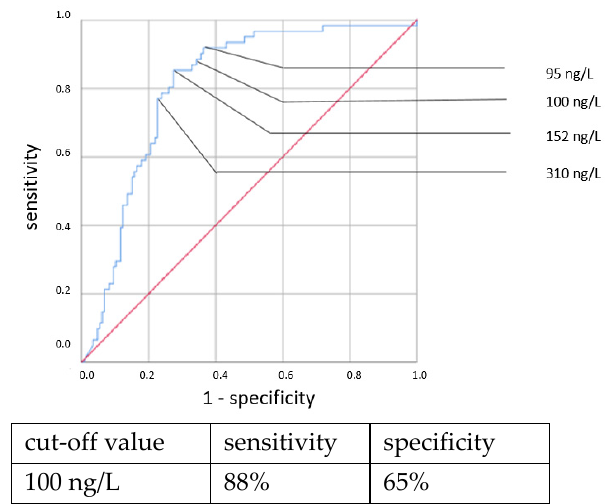
Figure 3. IL-6 concentration. Culture-positive LOS.